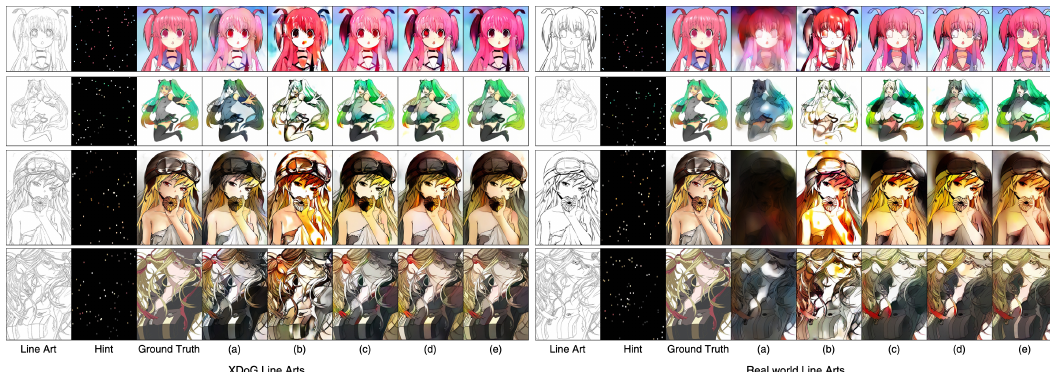
Figure 11. Visual comparison of color restoration ( a ): Base [10], ( b ): Pix2pix [2], ( c ): ours (LDM enabled line loss only), ( d ): ours (histogram equalization only), ( e ): ours (Both: LDM enabled line loss + histogram equalization).